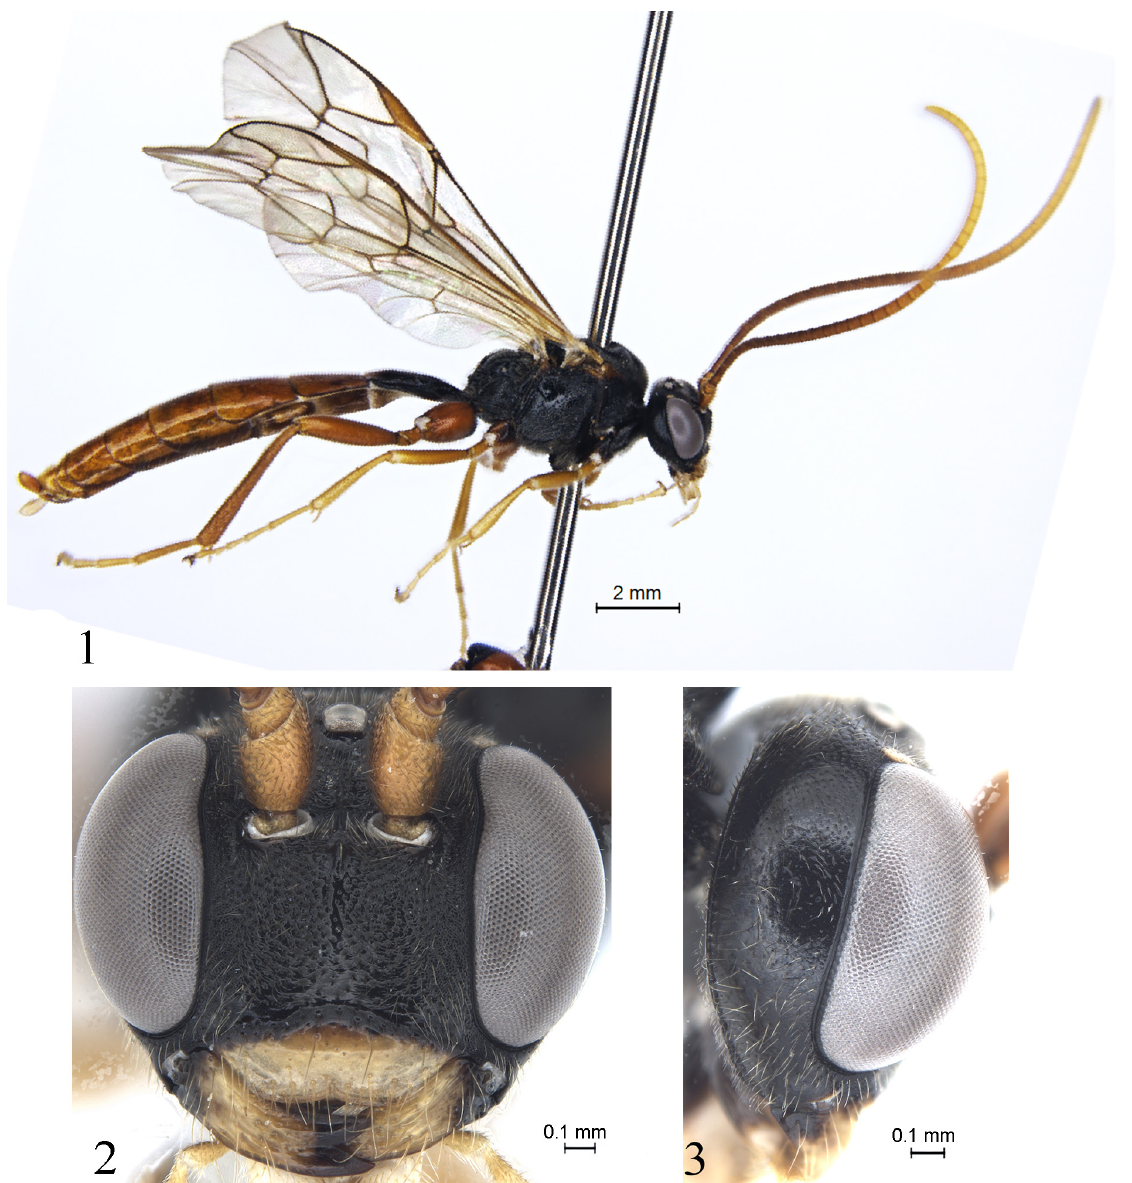
Figs 1–3. Ctenopelma labiatum Sheng, Sun & Li sp. nov., holotype, ♀ (GSFGPM). 1 . Habitus, lateral view. 2 . Head, anterior view. 3 . Head, lateral